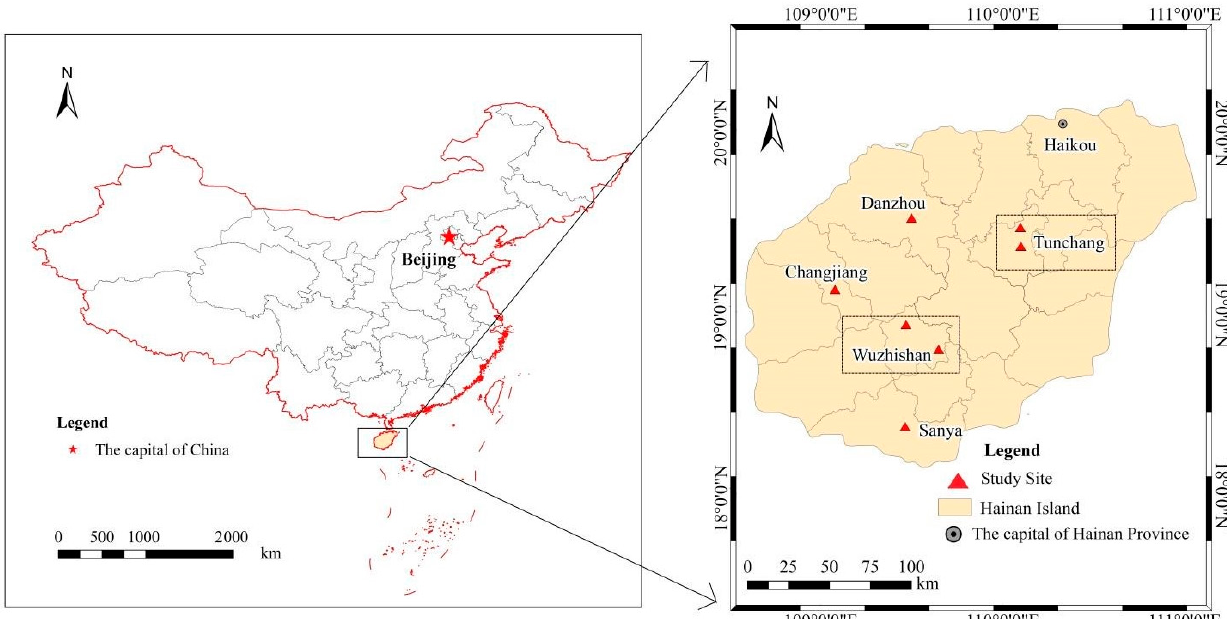
Figure 6. Experimental area and sampling sites.